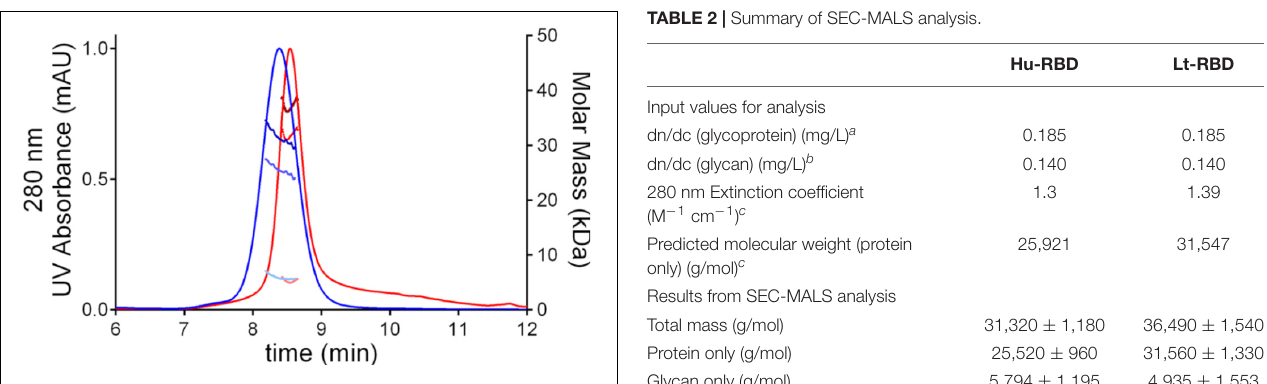
TABLE 2 | Summary of SEC-MALS